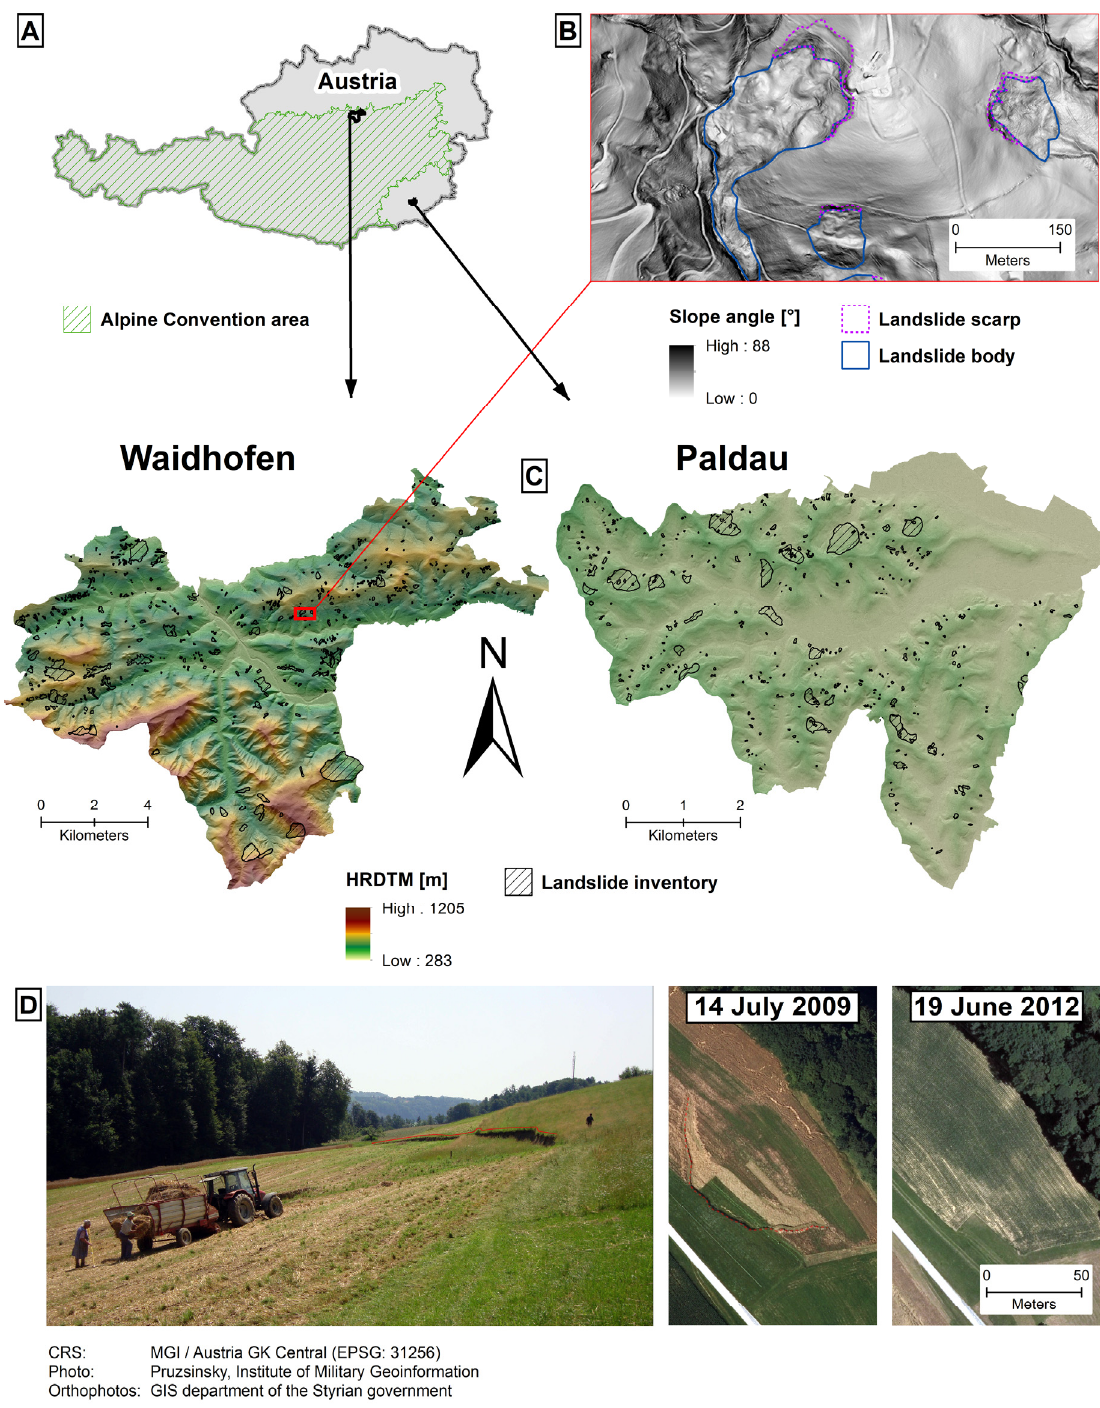
Figure 1. Overview of study area. ( A ): Location of study areas in Austria. ( B ): Landslides visible in Waidhofen’s slope map (red rectangle in ( C )). ( C ): HRDTM and derived landslide inventory. ( D ): A landslide on cropland in the district South East Styria, which occurred after an extreme rainfall event in June 2009, and “disappeared” in the following years. Photo taken on 23 July 2009.